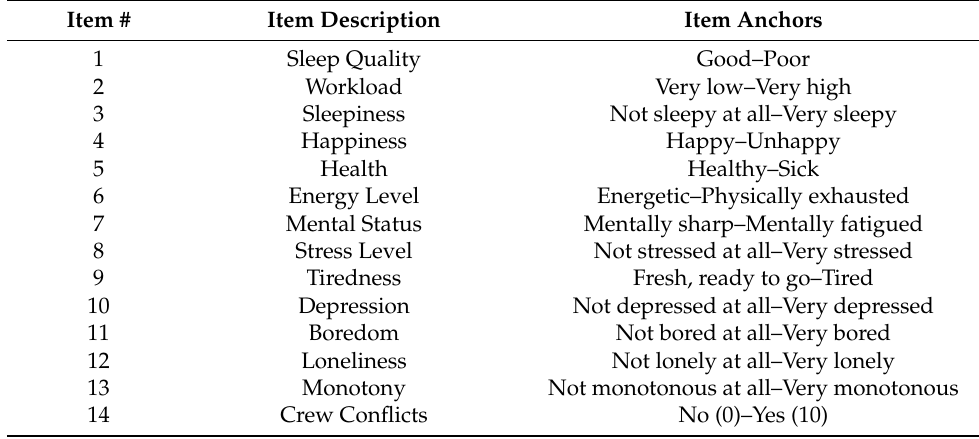
Table 1. Item description and item anchors for the paired